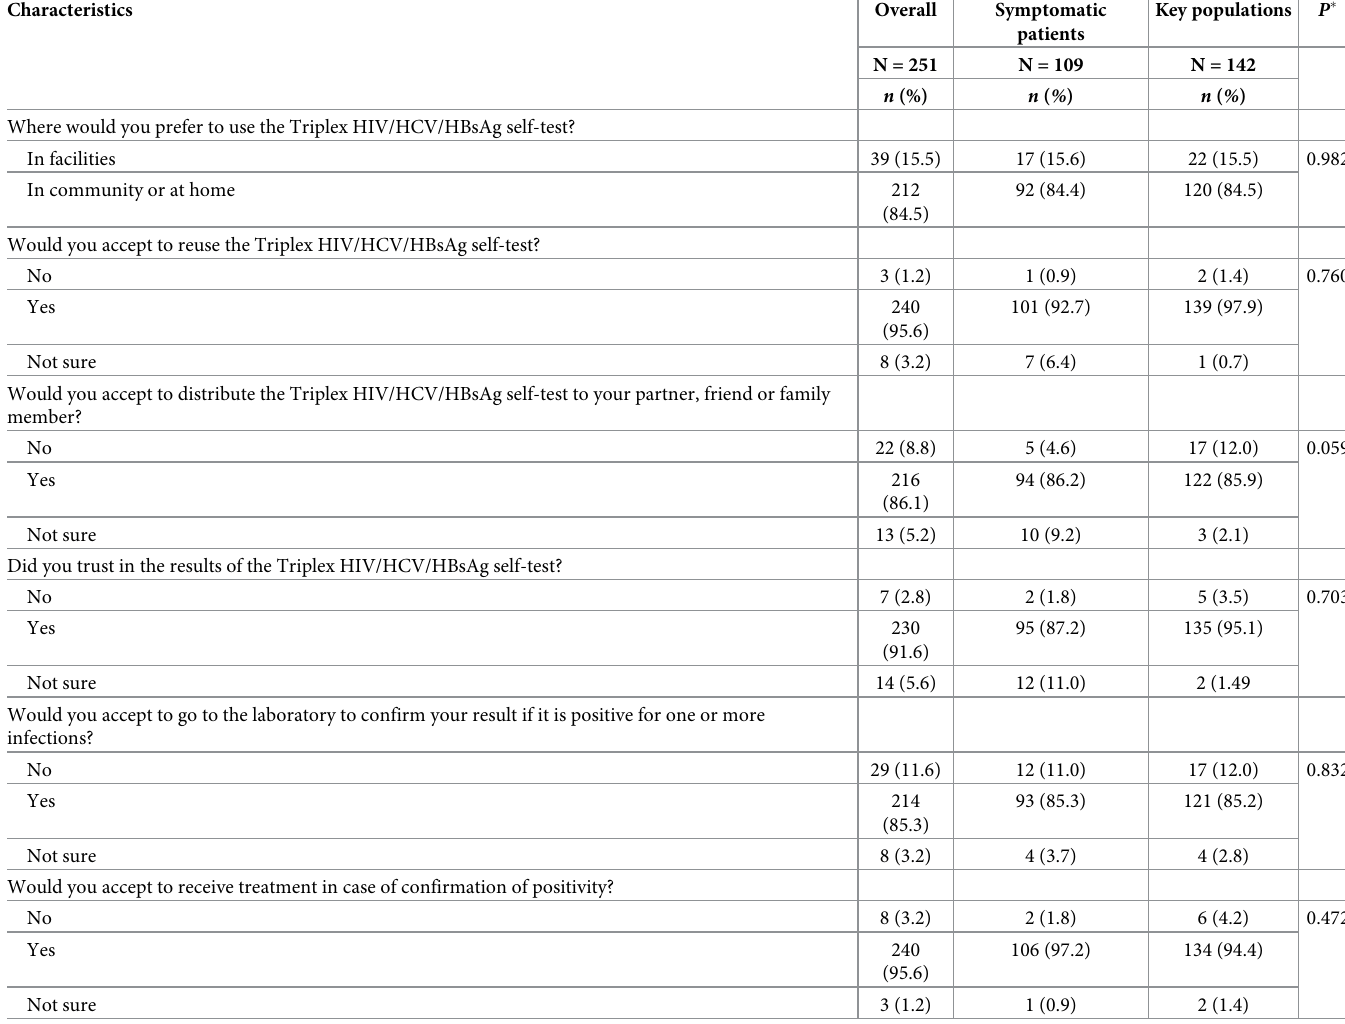
Table 6. Analytical results of the acceptability of and the preferences for the Triplex HIV/HCV/HBsAg self-test among 251 study participants.